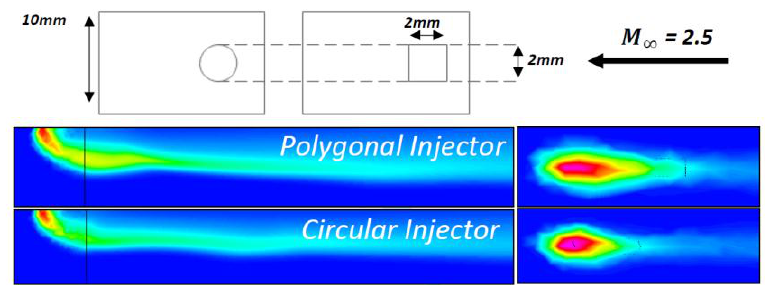
Figure 14. Cold flow injector performance in terms of Hydrogen mass fraction (%H Mass).